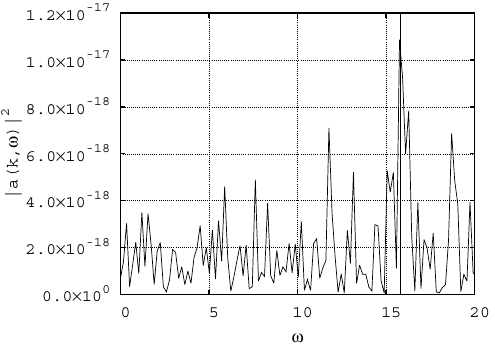
Figure 14. Spectral line of the harmonic k = (0, 250). Only the con- densate was suppressed.